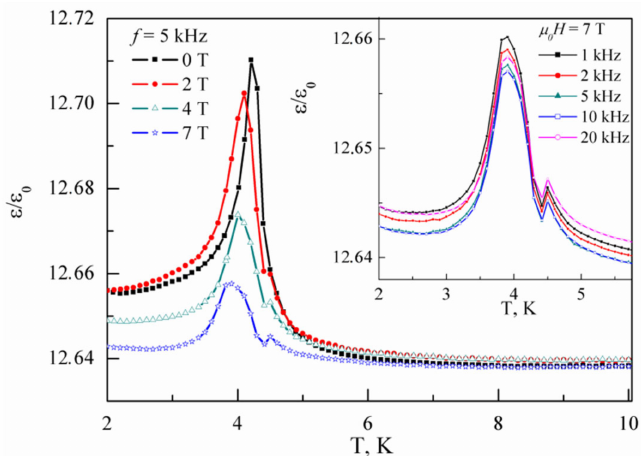
Figure 5. Temperature dependences of dielectric permittivity ε / ε 0 in PbCu(SeO 4 )(OH) 2 taken at f = 5 kHz in various magnetic fields. Inset: temperature dependences of dielectric permittivity taken at µ 0 H = 7 T for various